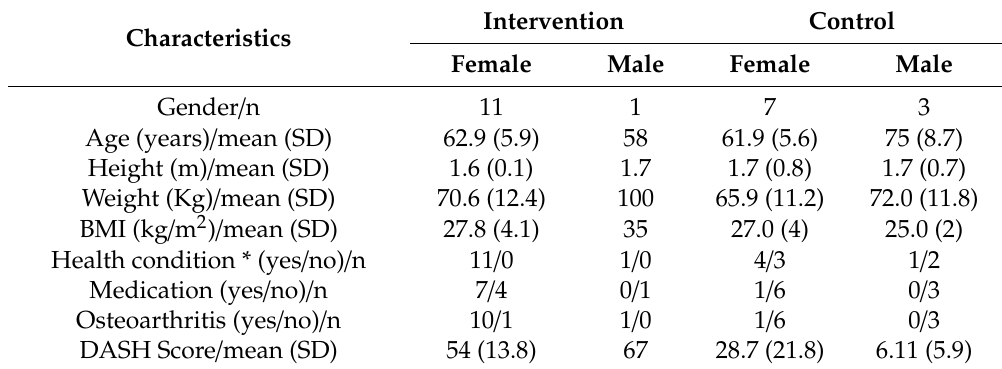
Table 1. Baseline characteristics of the participants (mean / standard deviation